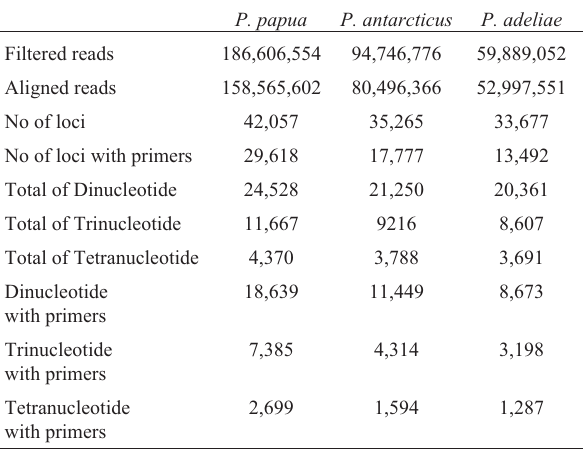
Table 1 - Number of reads (filtered and aligned), number of microsatellite loci and motifs for all three Pygoscelis species, including the total of loci and only those that showed flanking region sequence for primer